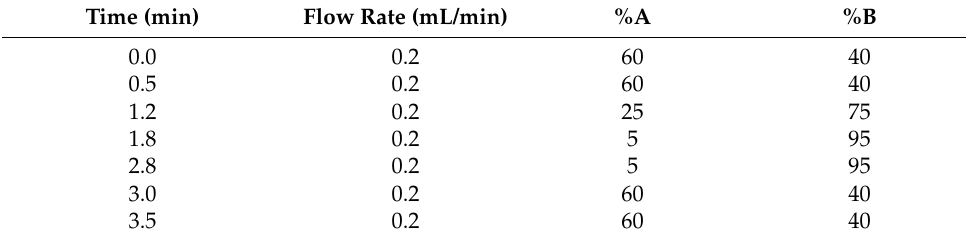
Table 1. UPLC-MS/MS gradient elution method for BVP